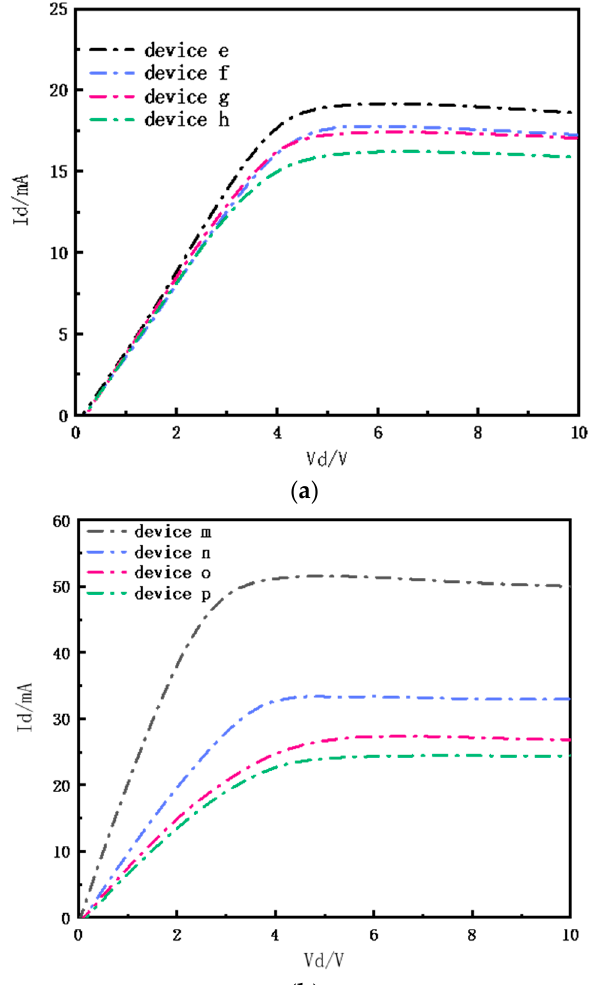
Figure 9. ( a ) Output characteristics of conventional structure devices with gate lengths of 3/4/5/6 μ m. ( b ) Output characteristics of ring-gate structure devices with gate lengths of 3/4/5/6 μ m.